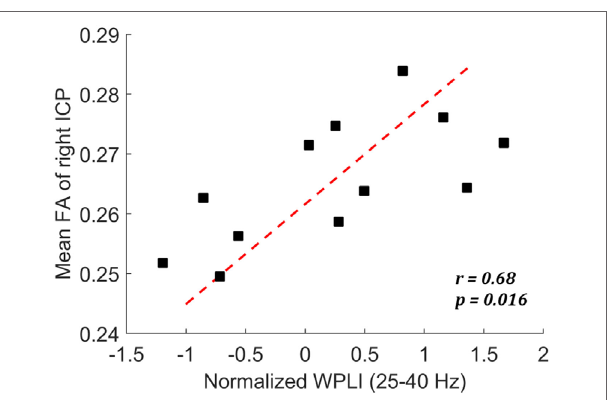
FigUre 3 | Scatter plot showing the correlation between mean fractional anisotropy (FA) of right ICP and the normalized weighted phase lag index (WPLI) at low-gamma frequency among the mild traumatic brain injury cases.